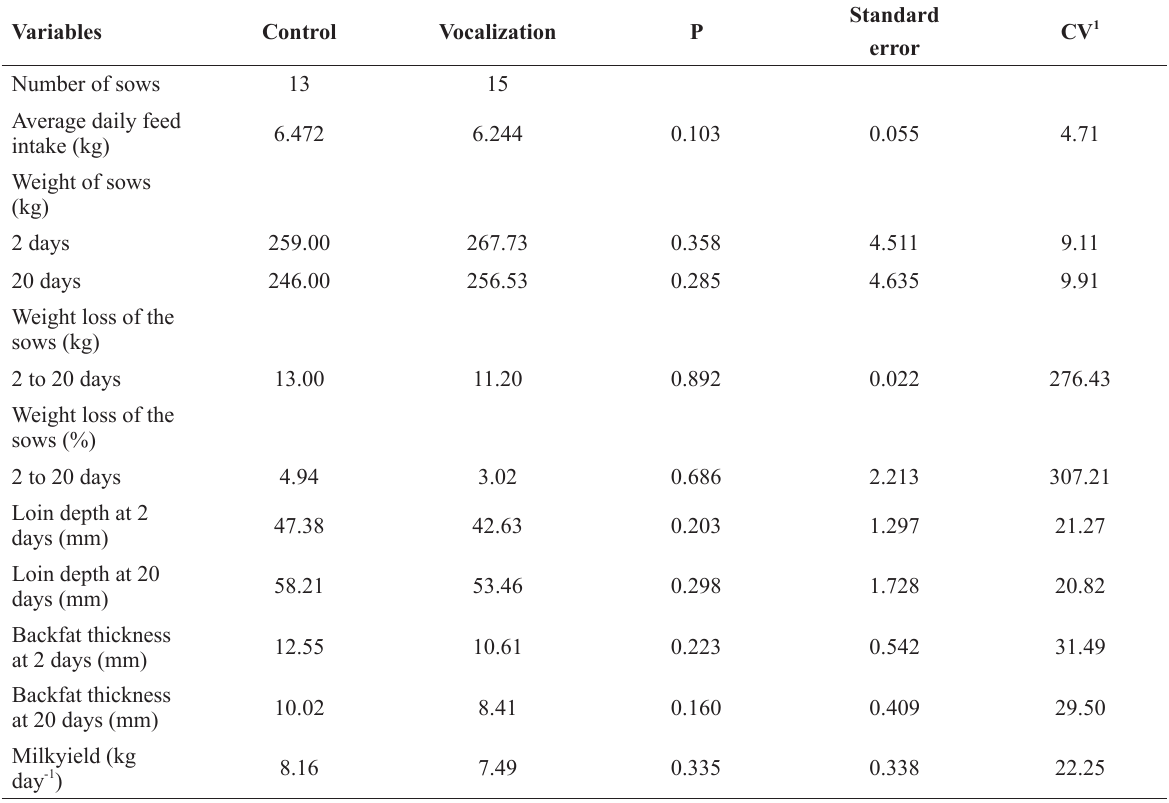
Performance and body condition of sows due to the use of artificial vocalization or not during